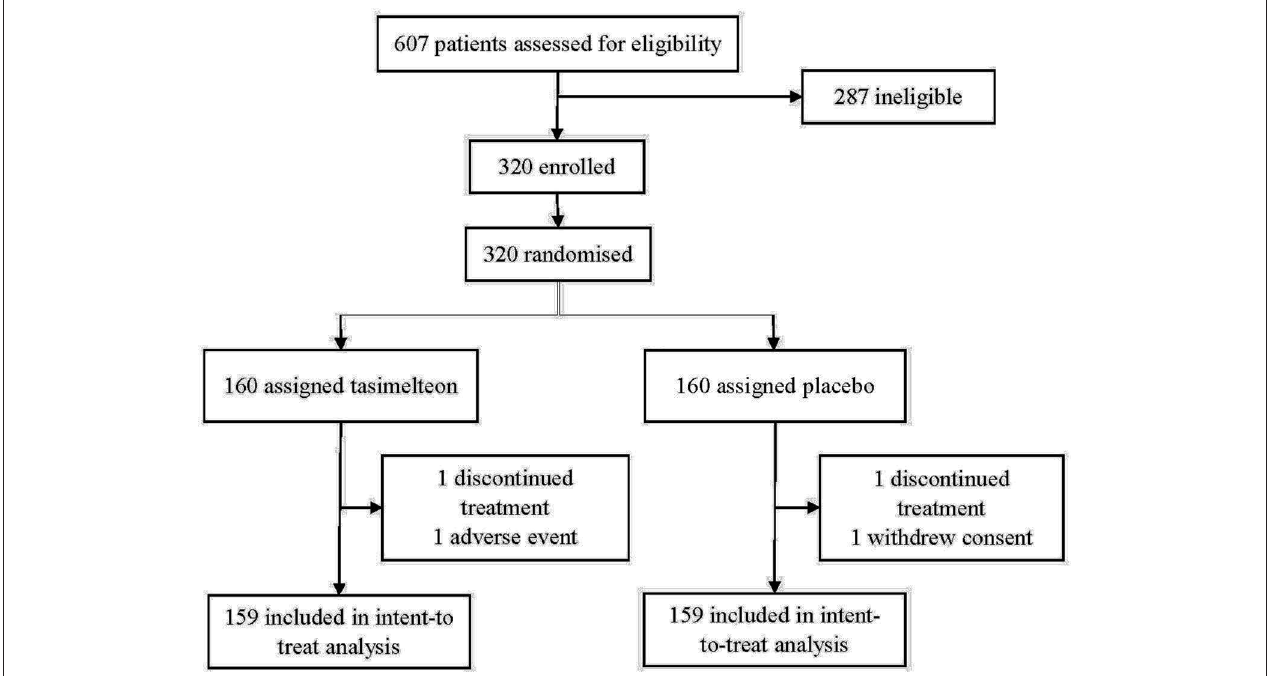
FIGURE 3 | Number of patients screened, enrolled, randomized, and discontinued for the JET8 study.